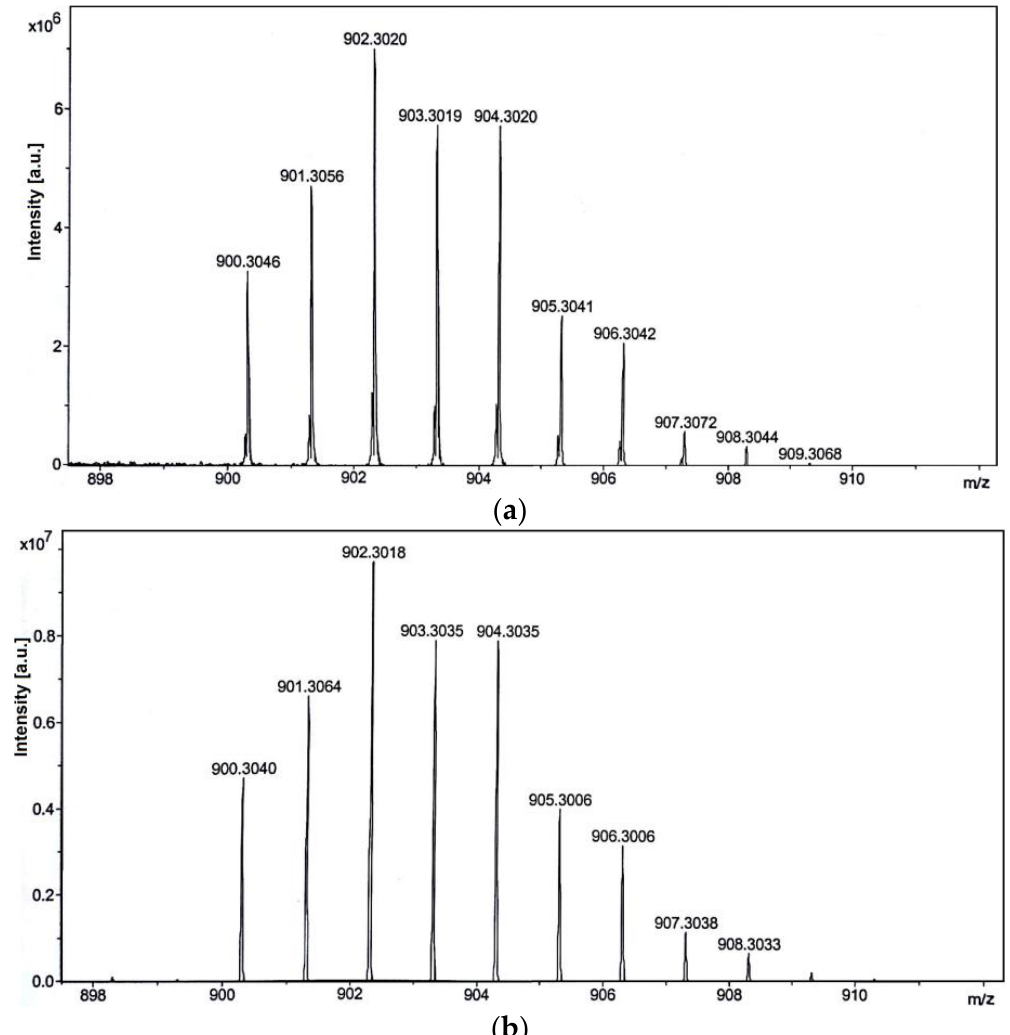
Figure A1. HR-ESI-MS of BATRISPt negative mode: ( a ) measured; ( b ) calculated spectra for {BATRISPt–[K(18-cr-6)]} − ion.